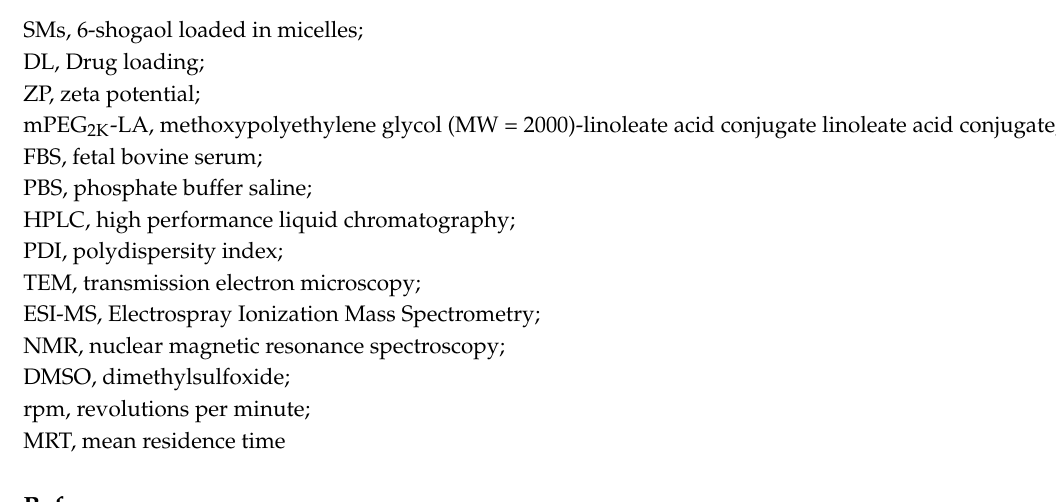
Figure S1: The ESI-MS of 6-shogaol, Figure S2: The 1 H-NMR of 6-shogaol (CDCl3, ppm), Figure S3: The chromatogram of purified 6-shogaol and the structure of 6-shogaol (insert), Figure S4: HPLC chromatograms of blank micelles (A), 6-shogaol (B) and sample of 6-shogaol-loaded micelles (C), Figure S5: Chromatograms of 6-shogaol and internal standard in rat plasma, Figure S6: Chromatograms of 6-shogaol and internal standard in mouse heart, liver, spleen, lung, kidney, brain, stomach, intestine homogenate and plasma. Figure S7: The gel chromatogram of mPEG 2k -LA and mPEG 2k -LA after incubation at PBS = 7.4 for 24 h, Figure S8: Synthesis route of mPEG2k-LA, Figure S9: The critical aggregation concentration (CAC) of mPEG 2k -LA micelles was measured by Fluorescence probes (pyrene), Figure S10: The TEM micrograph of 6-shogaol loaded micelles (6-shgoaol/mPEG 2k -LA = 1/10). Table S1: Linear ranges, standard curves and regression coefficients of 6-shogaol in different biosamples. Table S2: The precision (intra-day and inter-day precision), accuracy (relative recovery) and extract recovery of analysis method in